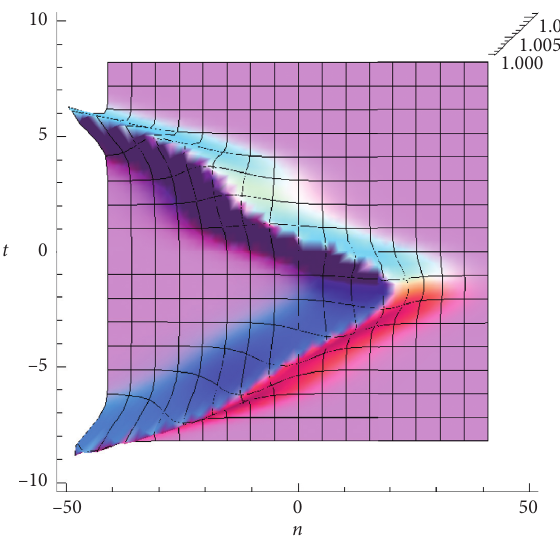
Figure 1: Spatiotemporal structure of semidiscrete one-soliton solution (69) with the parameters α � sech t , c ( 0 ) � 1, k � 3, and z α 3 1